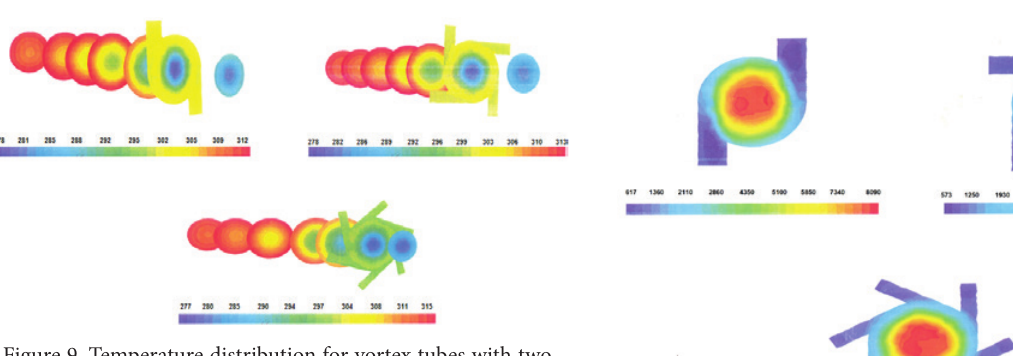
Figure 9. Temperature distribution for vortex tubes with two, four and six inlet nozzles